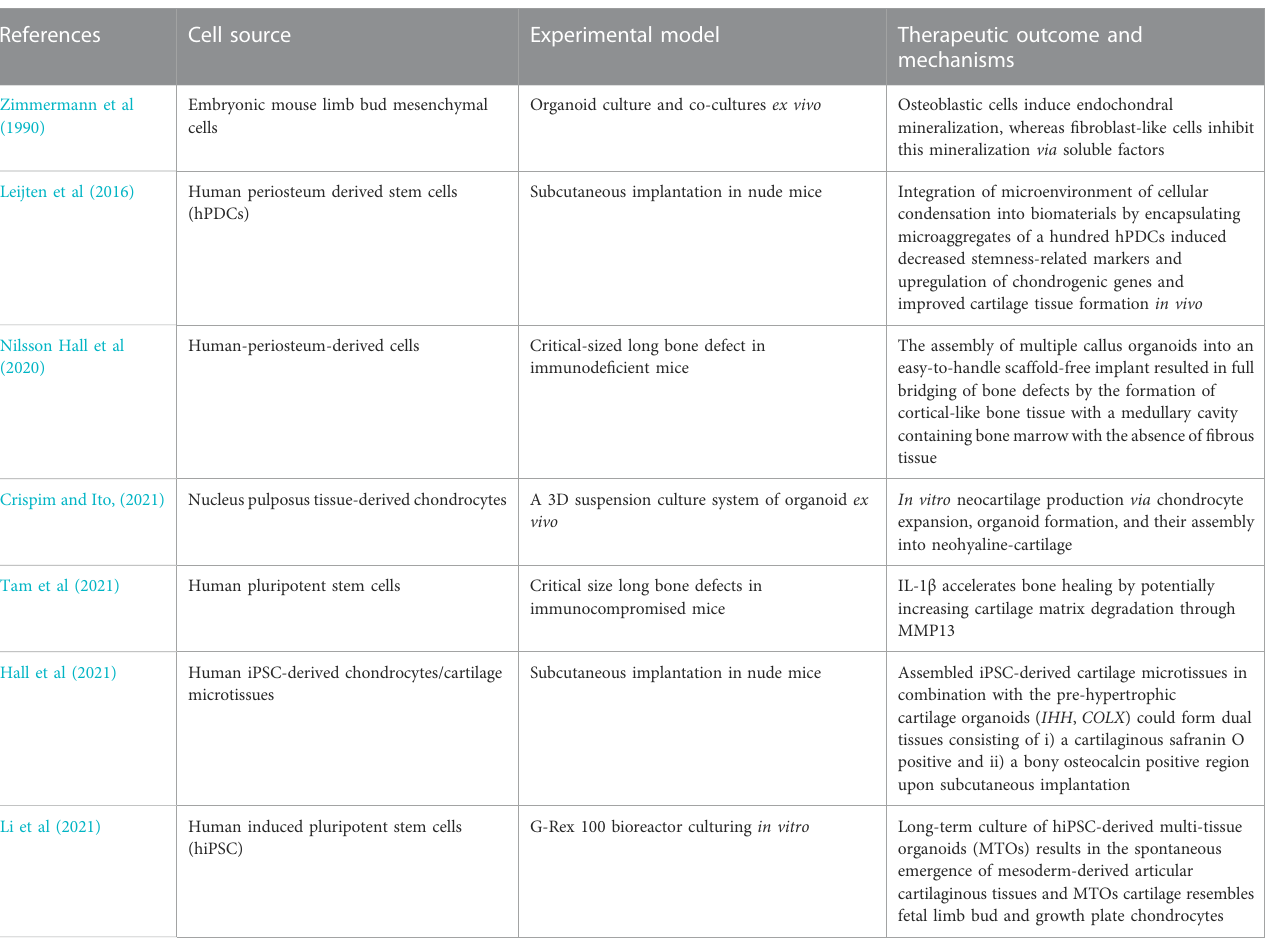
TABLE 1 Advancements of cartilage organoid